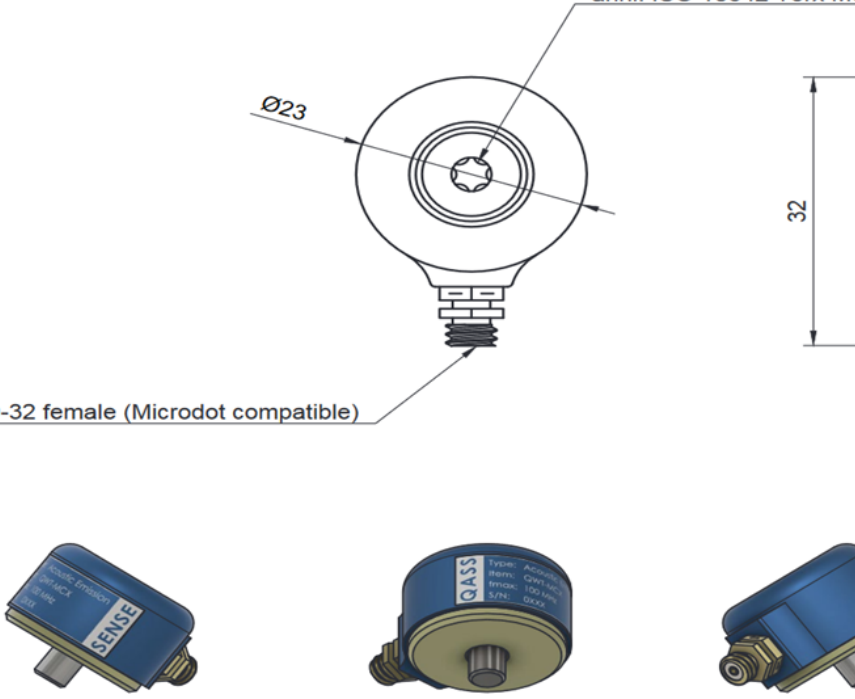
Figure 3. Used acoustic-emission sensors.